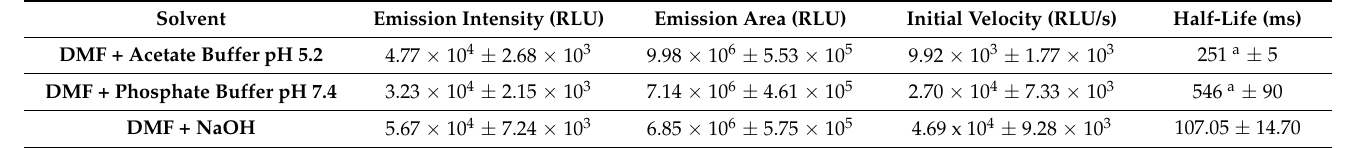
Table 3. Light-emission intensity maxima (in RLU), area of emitted light (in RLU), initial velocities (in RLU/s), and half-life(s) of the CL reactions of MeOBr-Cla in DMF with the addition of either sodium acetate buffer pH 5.2 (1%), phosphate buffer pH 7.4 (75 mM), or NaOH (0.1 M). Assays were performed for a final volume of 500 µ L and a MeOBr-Cla concentration of 10 µ M. Typical integration times for CL measurements were 0.1